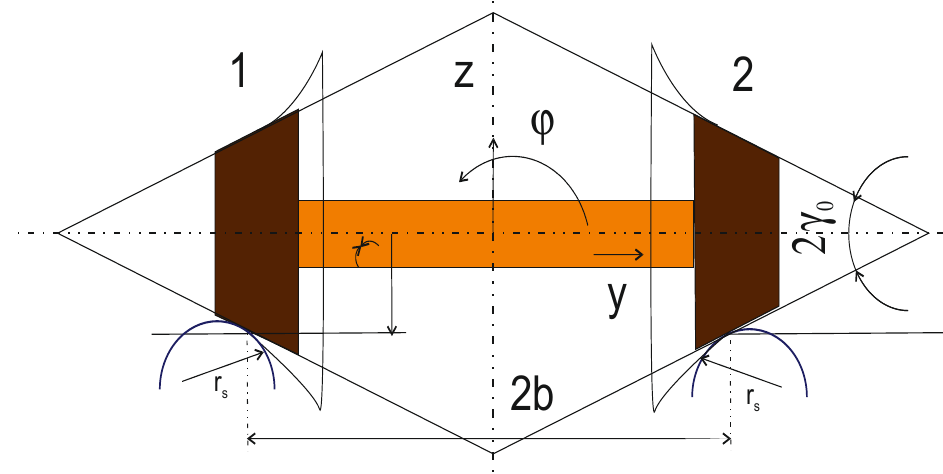
Figure 4 . Geometry model of the wheelset–track system (wheelset in middle position) where 1— Outer rail (left), 2—Inner rail (right) [16].